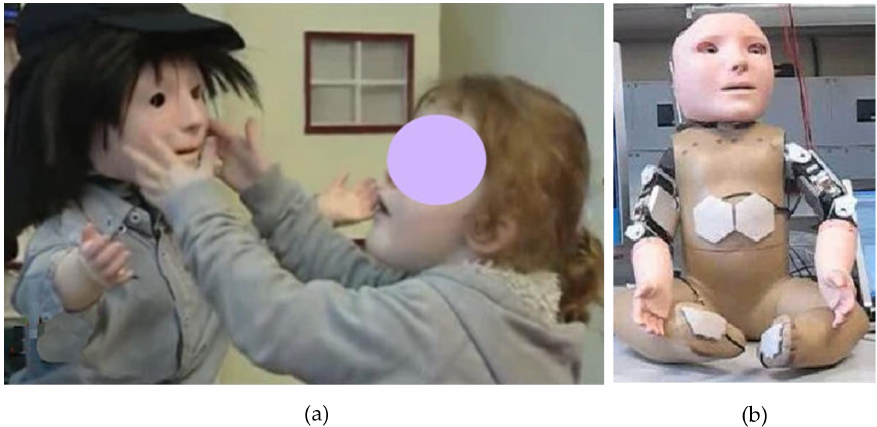
Figure 6. Interactions between a child and a touch-sensitive social robot. ( a ) Games with tactile contact interaction; ( b ) Hexagon-shaped tactile skin patches on the robot KASPAR. (With kind permission from Springer Science + Business Media, adapted from